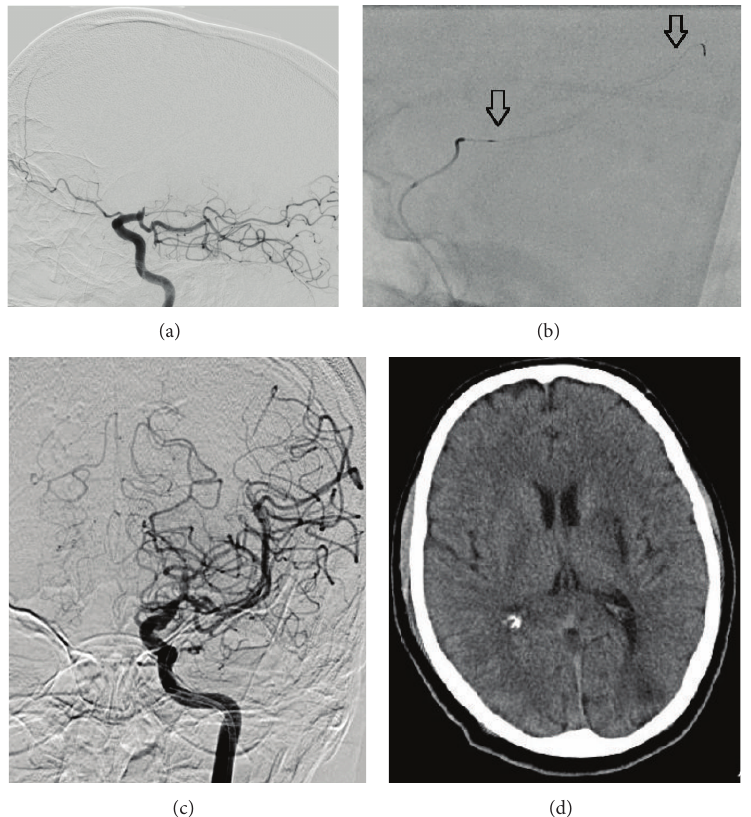
Figure 2: (a) DSA reveals persistent carotid T occlusion and fresh thrombus on the occluded segment. Fetal PCA is observed on the lateral projection (black arrow). (b) Deployed Trevo-ProVue device (distal and proximal markers = black arrow). (c) After two passes with Trevo device, successful recanalization was achieved (TICI 2b). Both anterior cerebral arteries are filled from right hemisphere. (d) Control CT scan shows small infarction on basal